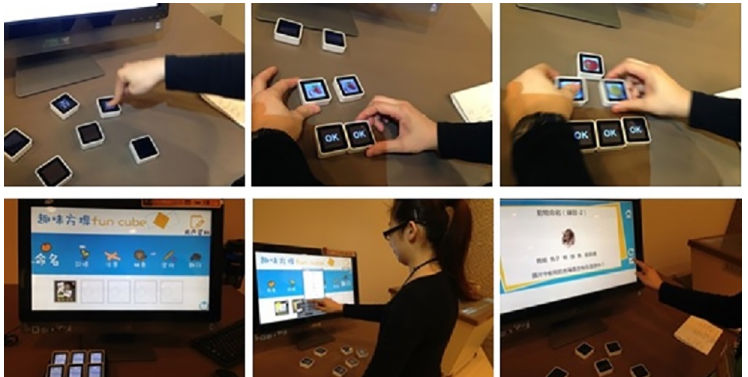
Fig 5. Fun Cube. The Fun cube comprises different types of games (with demonstrations) for such activities as memory training, sorting, pairing, and basic arithmetic.